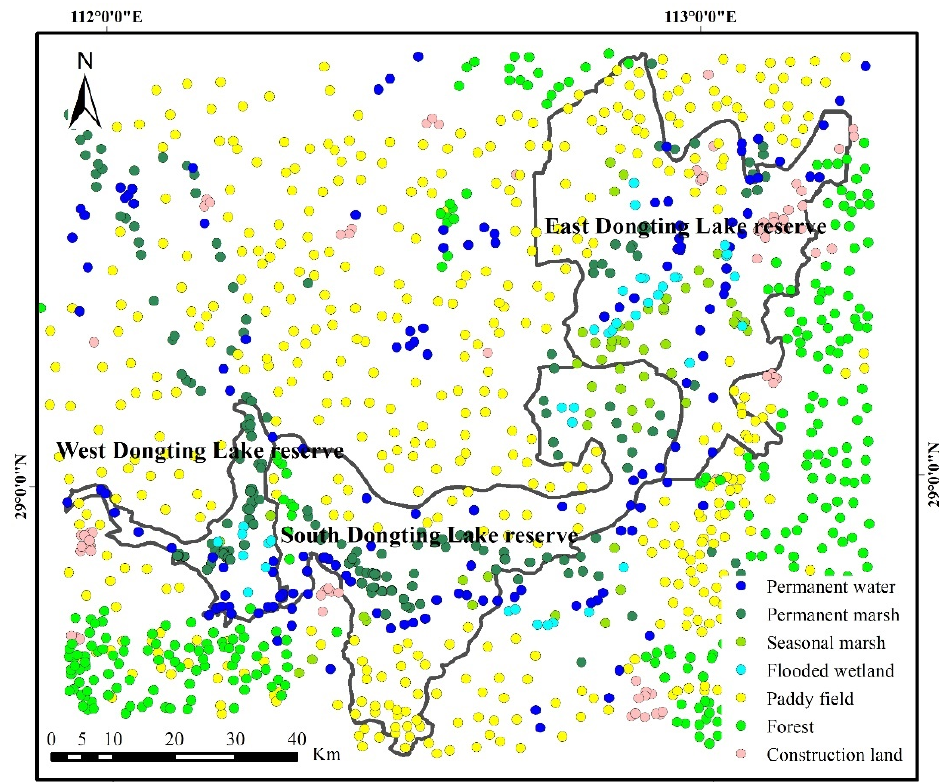
Figure 2. Distribution of samples for each land cover type in 2020.